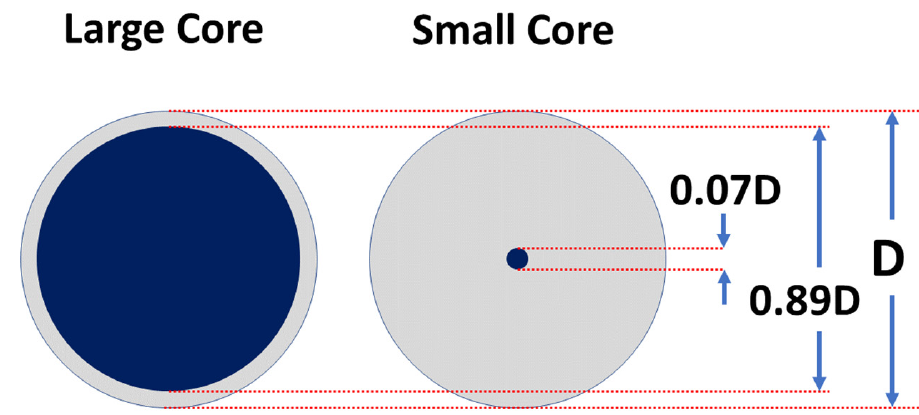
Figure 2. Visual comparison of relative core sizes of the SCF and LCF samples.